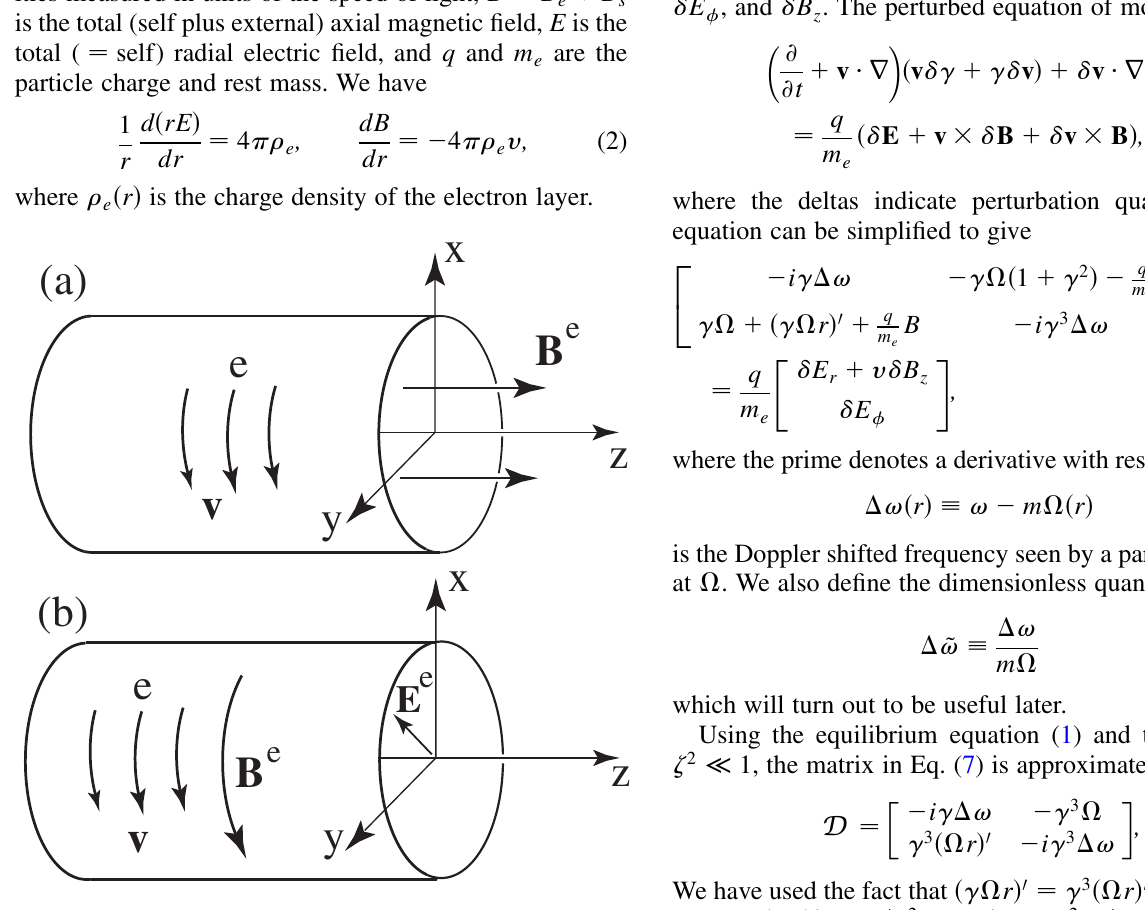
FIG. 1. Panel (a) shows the geometry of a relativistic E-layer for the case of a uniform external axial magnetic field. Panel (b) shows the second case of a relativistic E-layer in an external toroidal magnetic field and an external radial electric